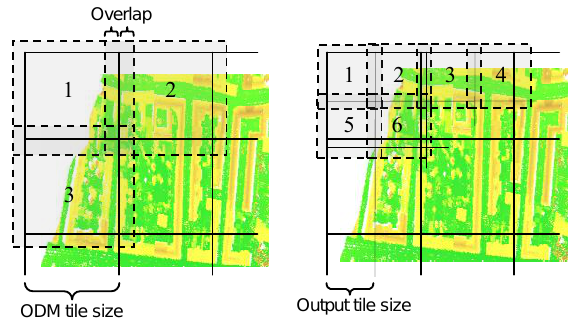
Figure 8. Processing strategy of opalsNormals (left) and opalsGrid (right)